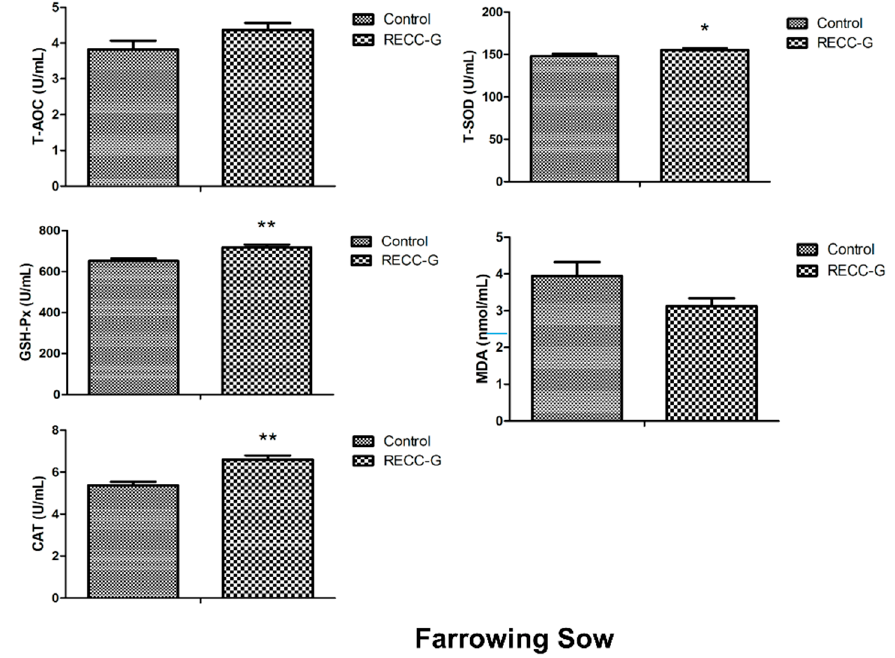
Figure 1. Effect of maternal REE supplementation on growth hormone (GH) and insulin-like growth factor-1 (IGF-1) secretion of their piglets. n = 8 per group. Values are mean ± SEM. ** p < 0.01.